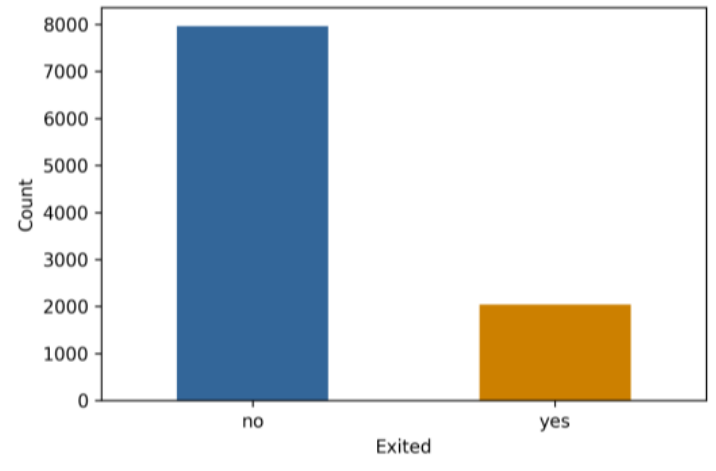
Figure 3. Distribution of dataset 1